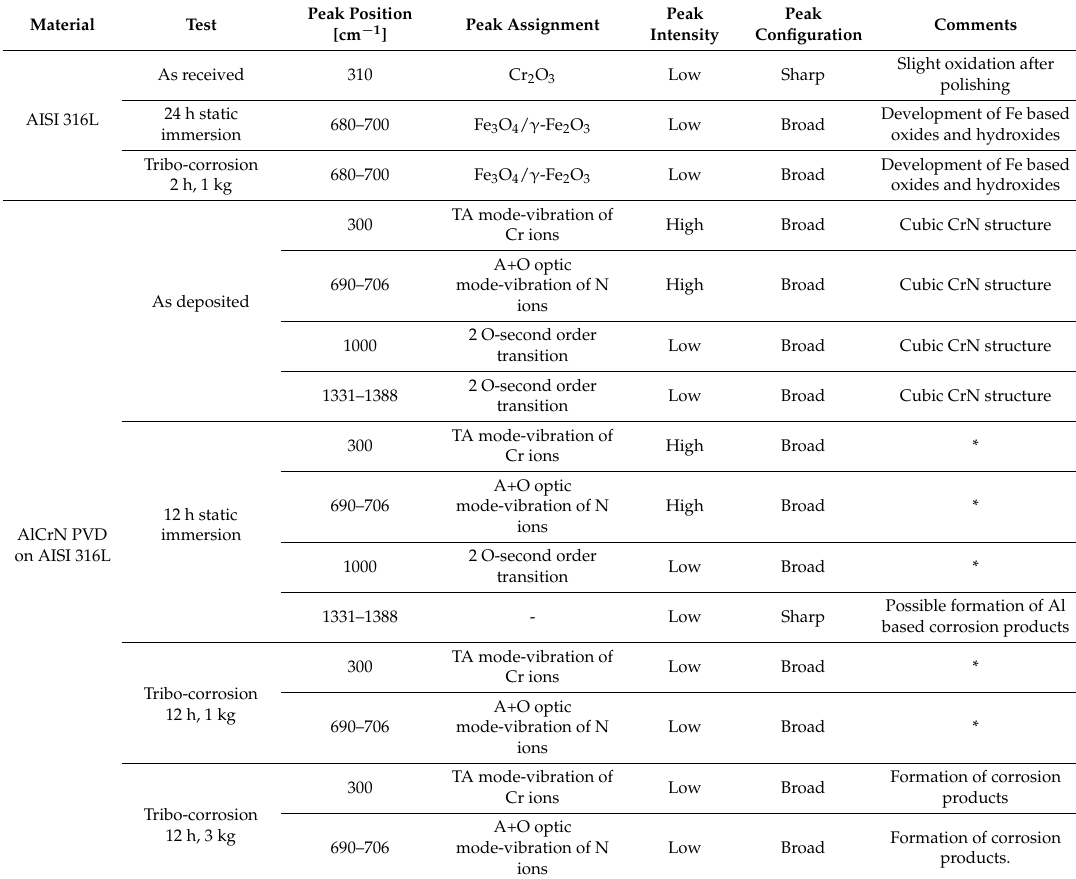
Table 4. Assignment of Raman peaks before and after corrosion and tribo-corrosion